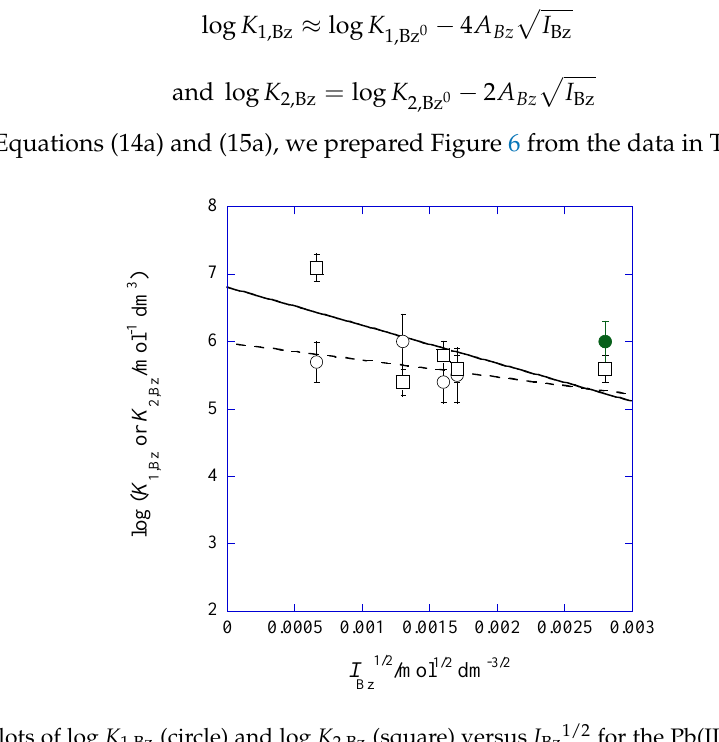
Figure 6. Plots of log K 1,Bz (circle) and log K 2,Bz (square) versus I Bz1/2 for the Pb(II) extraction with Cd(NO 3 ) 2 and B18C6 into Bz. The regression lines were based on Equations (14a) and (15a). The full circle was omitted from the regression analysis of log K 1,Bz .